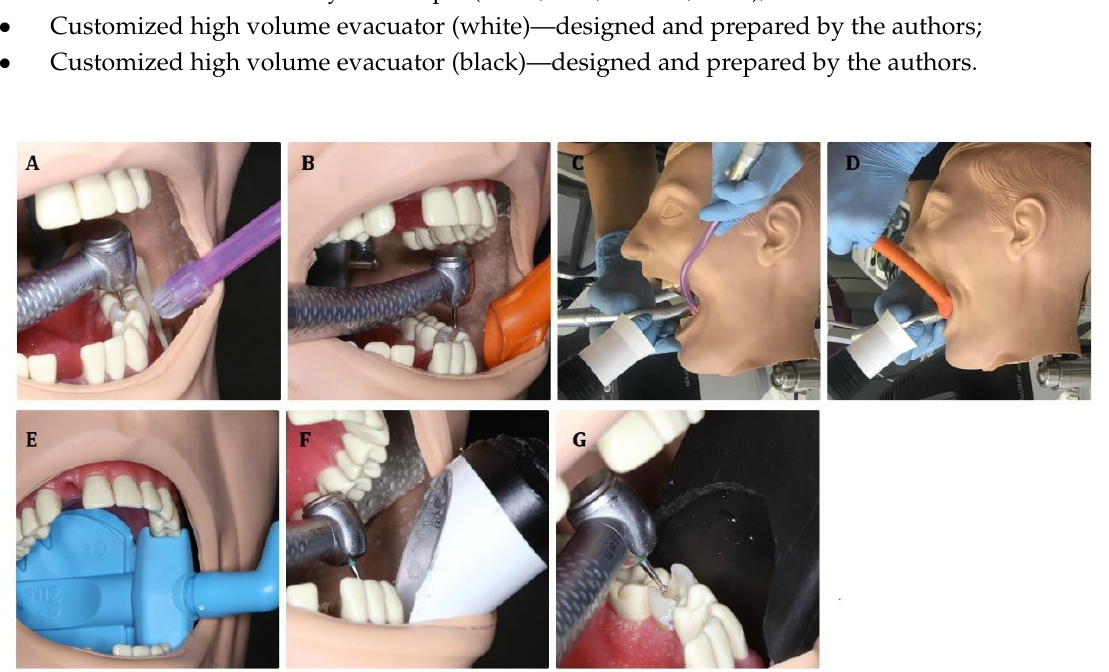
Figure 4. The suction systems used in the study. ( A ) Saliva ejector. ( B ) High volume evacuator. ( C ) Saliva ejector with an extraoral vacuum. ( D ) High volume evacuator with an extraoral vacuum. ( E ) Zirc ® evacuator. ( F ) Customized high volume evacuator (white). ( G ) Customized high volume evacuator (black).